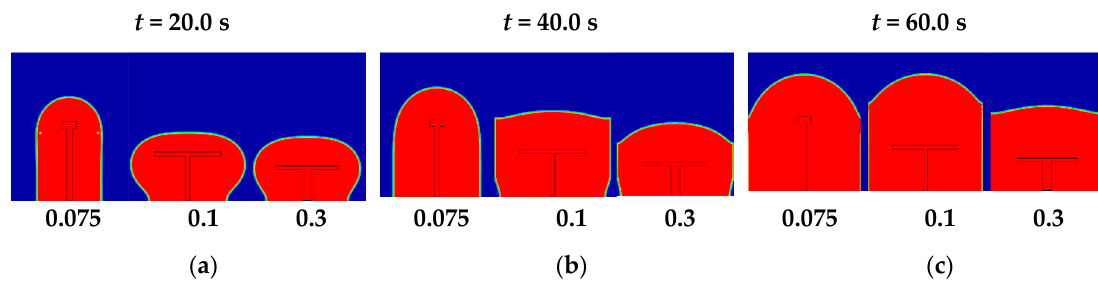
Figure 12. Effect of the ratio H 0 / H 1 for twice-minimized infusion time, t mm , and the respective optimal shapes, ( L 0 / H 0 ) o , ( L 1 / H 1 ) oo .